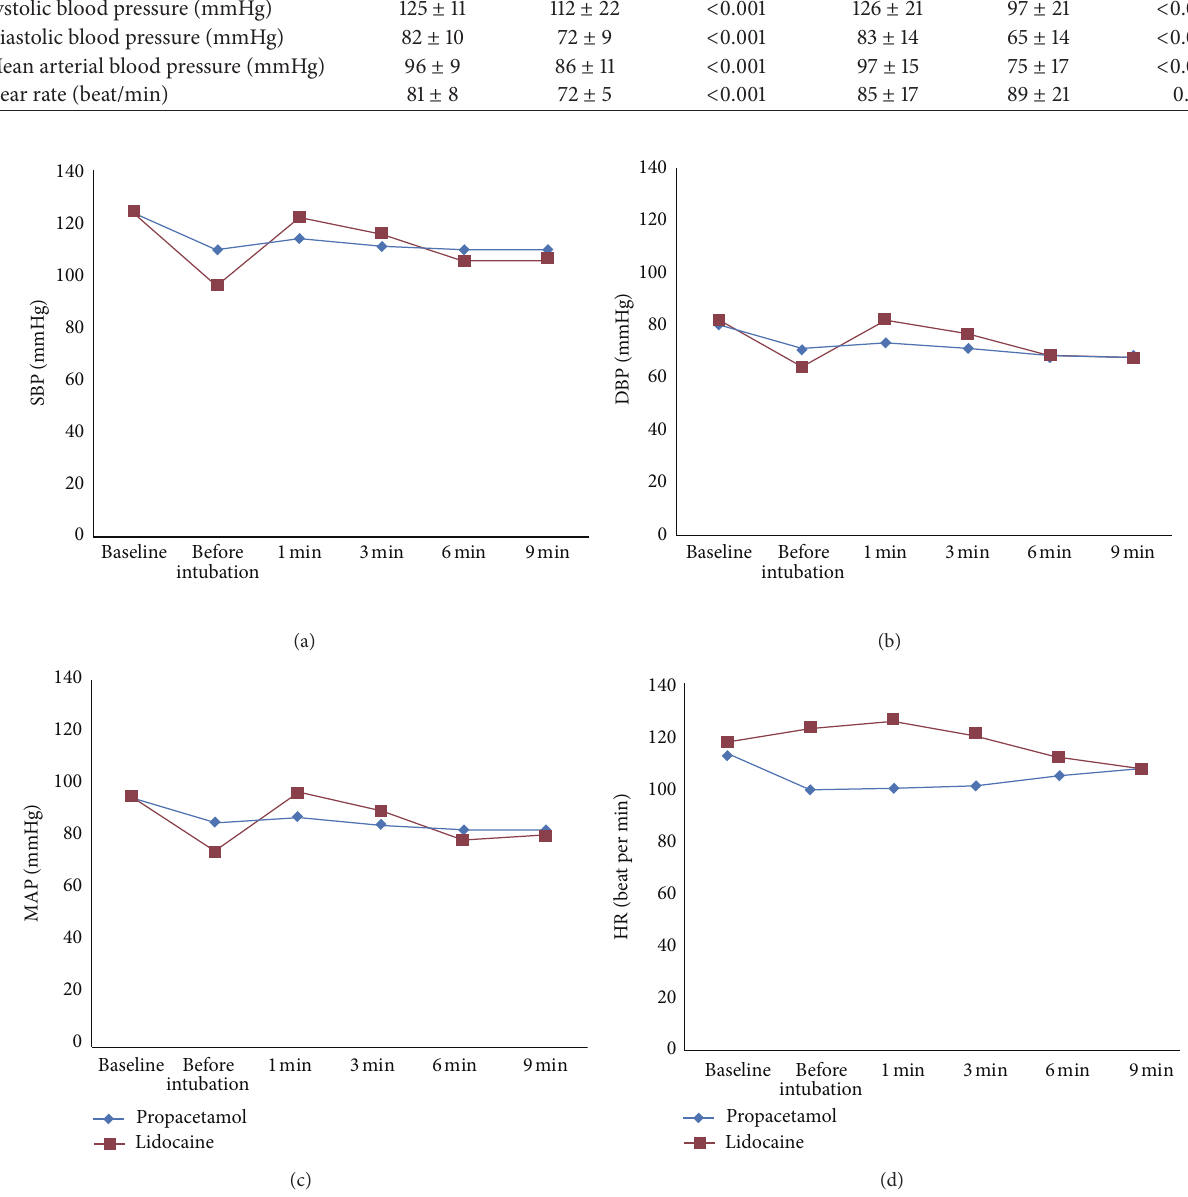
Figure 2: Hemodynamic status including systolic, diastolic, and mean arterial blood pressures (SBP, DBP, MAP) and heart rate (HR) within 9 minutes after tracheal intubation in each studied